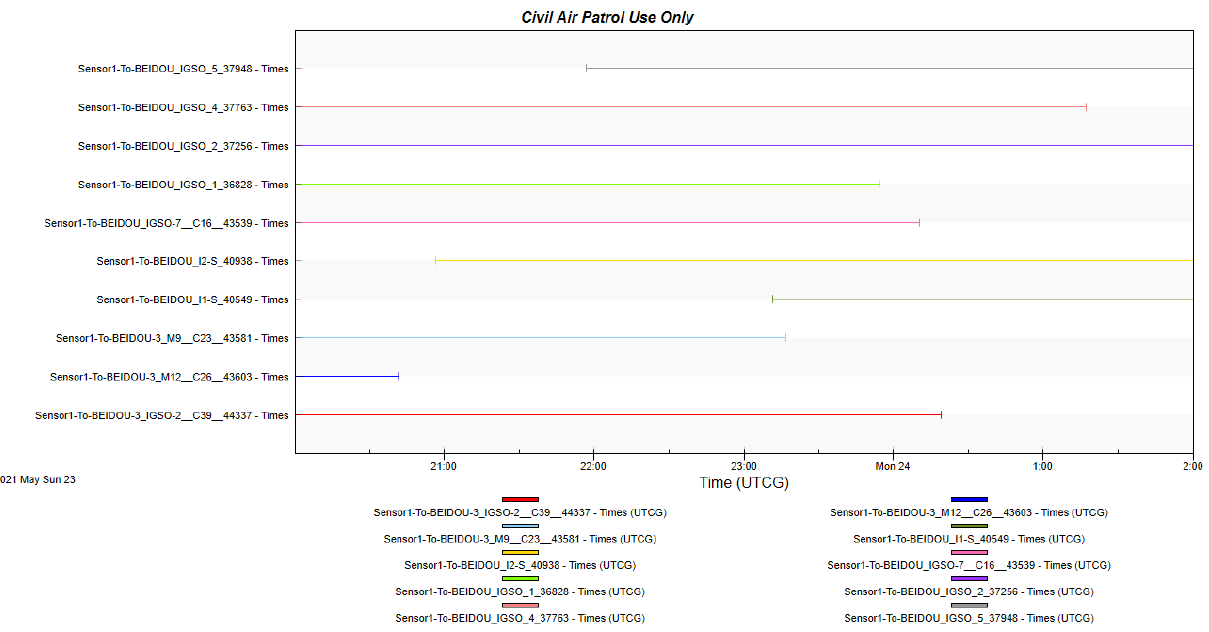
Figure 9. Simulation experiments of satellite visibility. The y -axis represents different satellites, and we use different colors to distinguish them. The x -axis represents the time interval. Each horizontal line represents the coverage time interval of each satellite. Take satellite IGSO_44337 as an example, which is located at the bottom of Figure 9 and is represented in red. This indicates that the link time of the satellite in the coverage area is from 20:00 to 00:20 on the 24th. The simulation results can visualize the link time between the observation satellite and the ground terminal. By ranking the longest link time, we can make a comparison with the grid calculation ranking results. The simulation results of the satellite-ground link in Figure 9 can show more intuitively that satellite IGSO_37256 has the longest visibility time throughout the whole calculation period, followed by satellite IGSO_37763, and the satellite IGSO_43603 has the smallest visibility time. The results for the longest satellite link time are approximately the same as those obtained from our grid calculations.